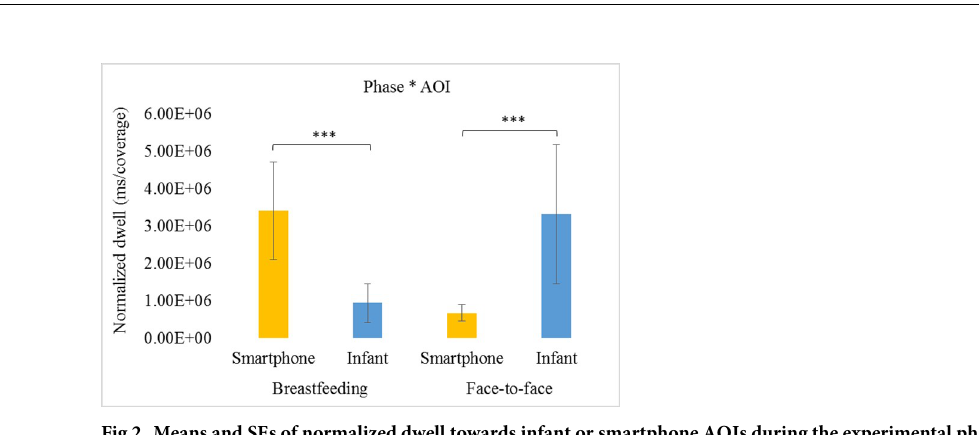
Fig 2. Means and SEs of normalized dwell towards infant or smartphone AOIs during the experimental phases. Normalized dwell refers to time differences measured in milliseconds in gaze patterns relative to the size of the AOI (ms/coverage). AOI = Area Of Interest (smartphone/infant). ��� p <